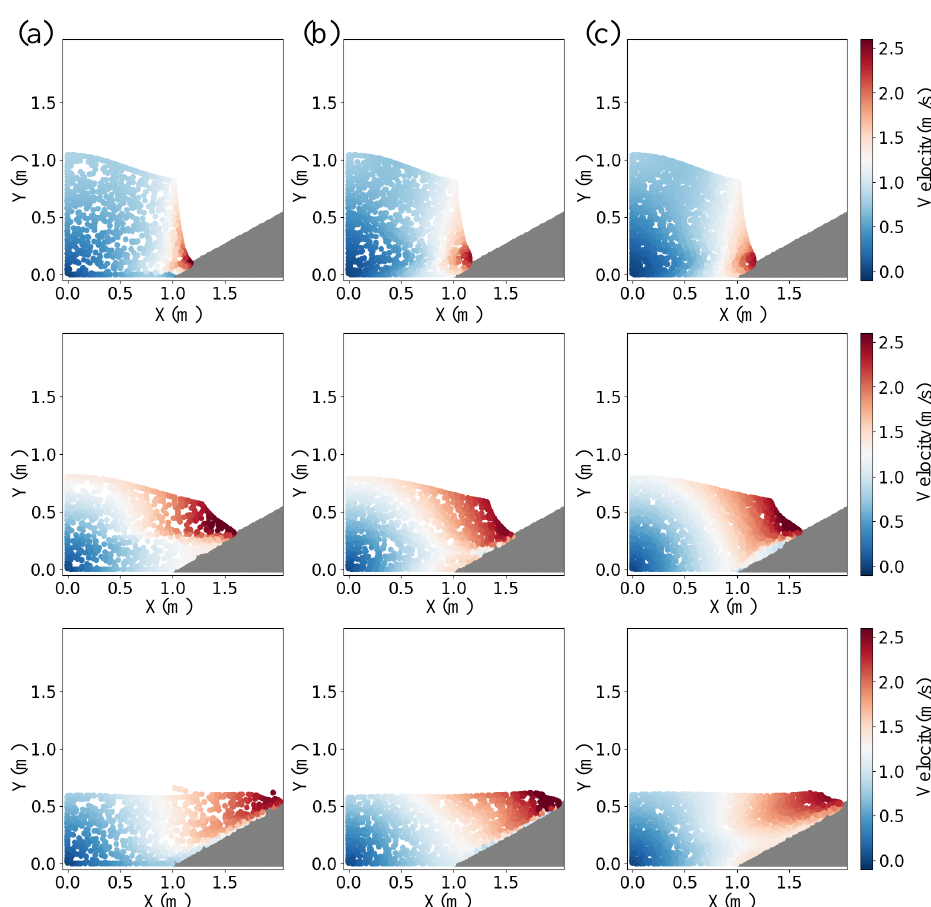
Figure 8. Simulation of velocity field for fluid climbing with different densities and randomly distributed particles at t = 0.14, 0.36, and 0.56 s. ( a ) Results from n = 700; ( b ) Results from n = 1000; ( c ) Results from n =